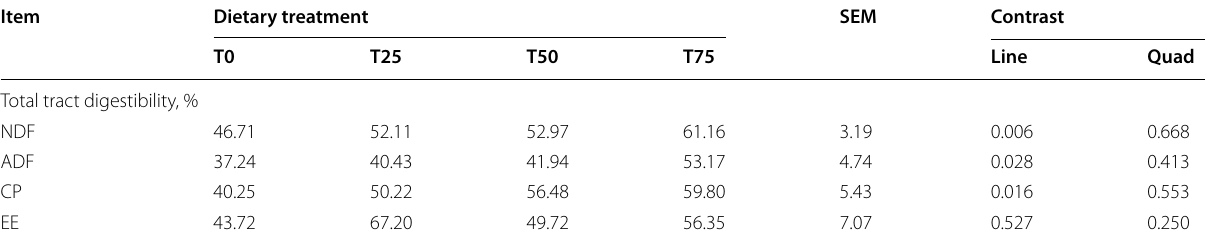
Table 1 Effects of BPS on apparent digestibility of Holstein